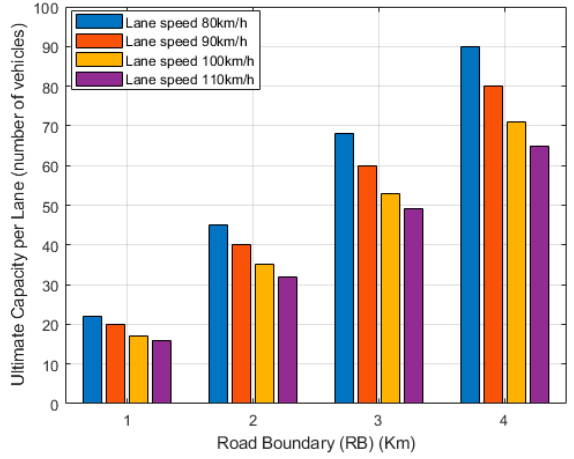
Figure 6. The lane vehicular capacity as a function of road stretch.